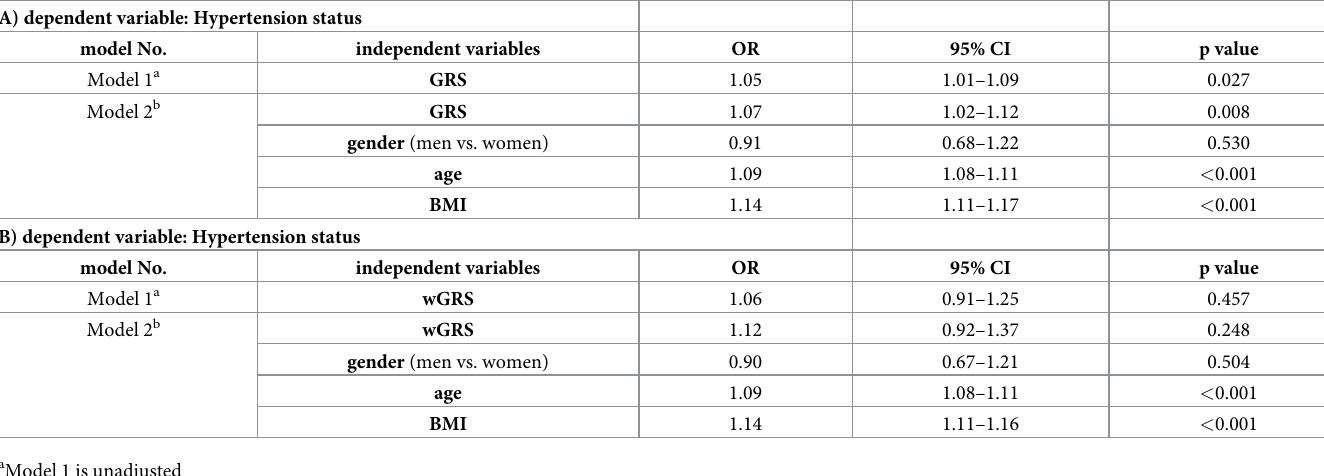
Table 4. Association between GRSs and hypertension risk in the Hungarian Roma